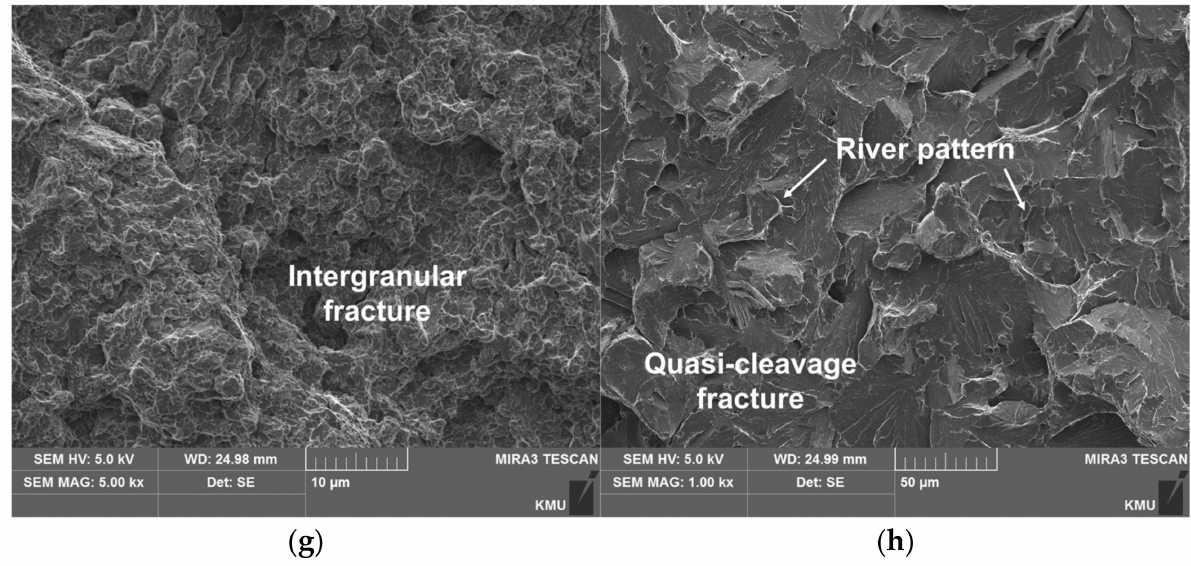
Figure 17. Fracture surfaces of the tensile specimens ( a ) carburized area of SCM420, ( b ) core of SCM420, ( c ) M2 de- posited layer, ( d ) substrate of as-built (M2) specimen, ( e ) deposited layer of as-built (FeCrVMoW), ( f ) substrate of as-built (FeCrVMoW), ( g ) deposited layer of as-built (FeCrVMoW)-PHT and ( h ) substrate of as-built